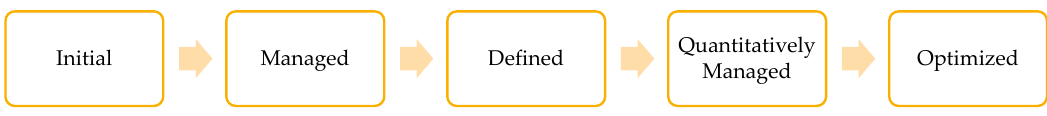
Figure 2. The levels in maturity models for energy and utility management (Source: [54]).